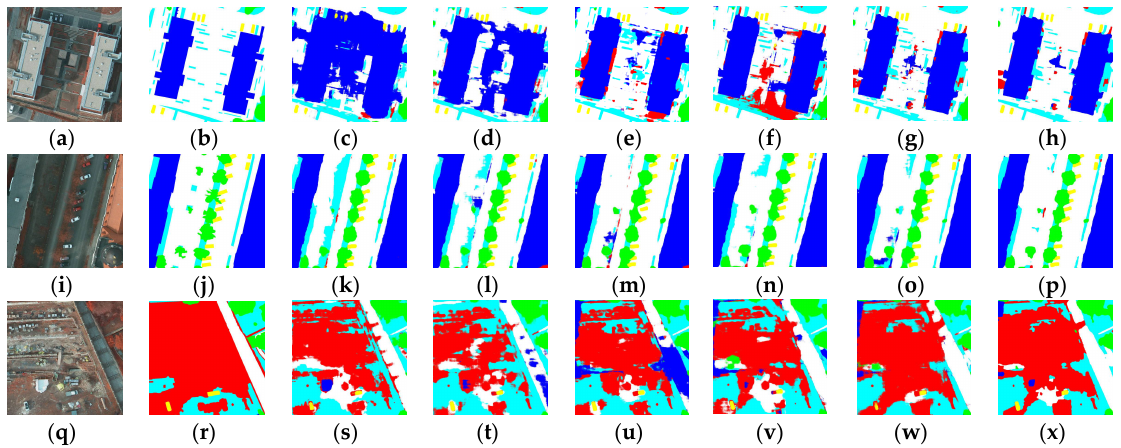
Figure 10. Semantic Labeling results for three patches of Potsdam test set. Classes: impervious surface (white); buildings (blue); low vegetation (cyan); tree (green); car (yellow); clutter (red). In the first row, ( a ) is true orthophoto, ( b ) is ground truth, ( c - h ) are inference results of FCN-8s, SegNet, FSN-noL, HSN, FSN and FSN+CRFs for image patch with buildings; in the second row, ( i ) is true orthophoto, ( j ) is ground truth, ( k - p ) are inference results of FCN-8s, SegNet, FSN-noL, HSN, FSN and FSN+CRFs for image patch with a street between buildings; in the third row, ( q ) is true orthophoto, ( r ) is ground truth, ( s - x ) are inference results of FCN-8s, SegNet, FSN-noL, HSN, FSN and FSN+CRFs for image patch with clutters.